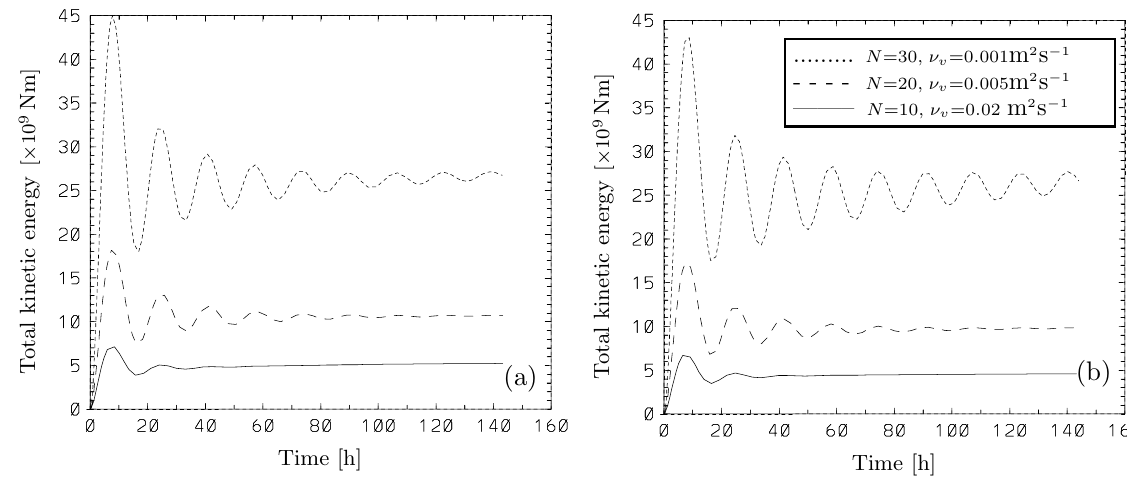
FIG. 6: Time series of the total kinetic energy in the rectangular basin subject to constant wind from the West in the long direction (a) and from the South in the cross direction (b) with three different vertical eddy viscosities (see inset, N = number of Chebyshev polynomials used).